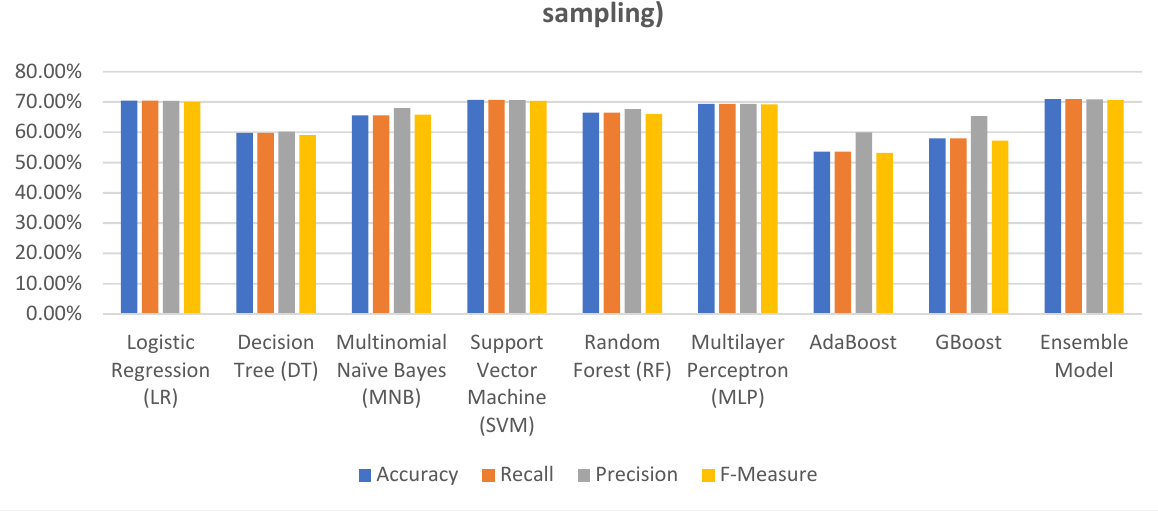
Table 8. Classification results for sentiment analysis of balanced dataset (oversampling). Balanced Dataset (Oversampling) (Features Extraction: